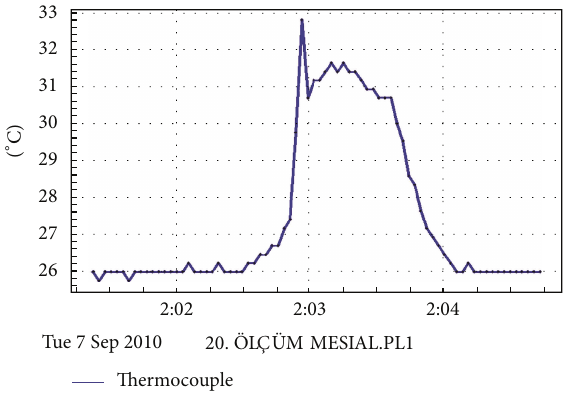
Figure 4: The monitor view of the computer program showing one of the outcomes of the temperature changes during laser